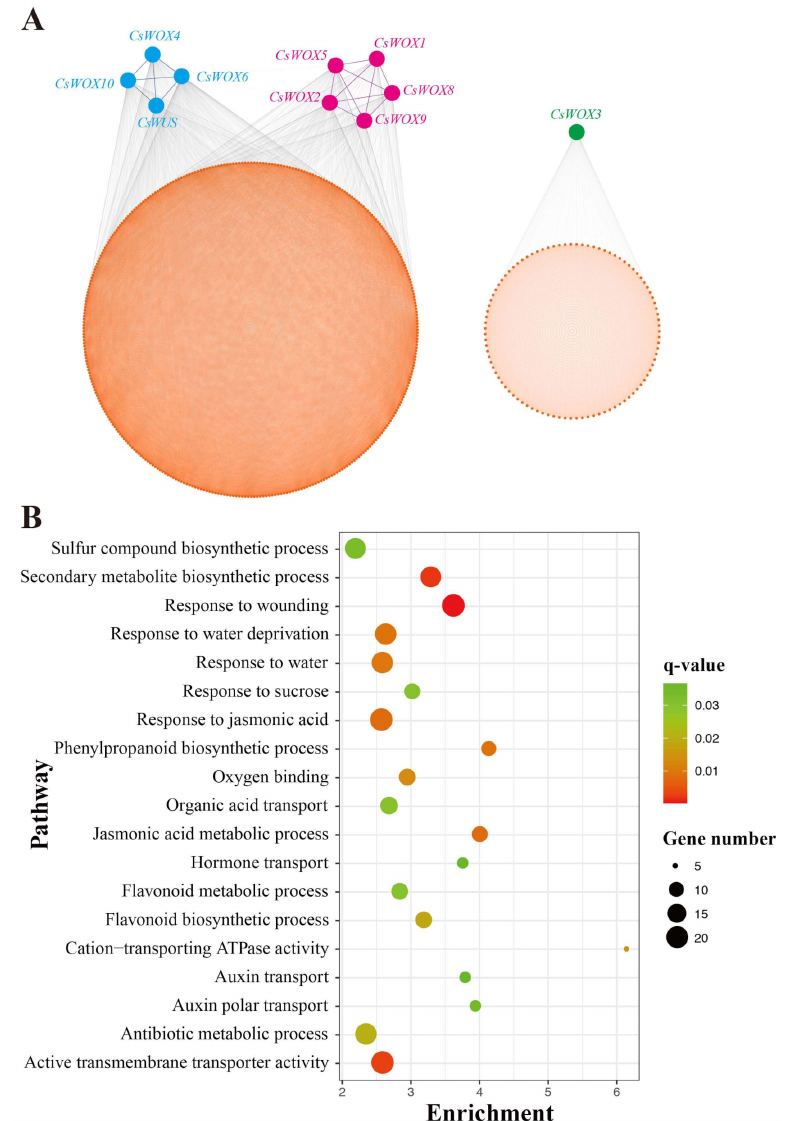
Figure 4. Co-expression network analysis of CsWOXs using data from a previous study [51]. ( A ) CsWOXs centered gene co-expression network under floral inductive water deficit. ( B ) Bio- logical processes of Gene Ontology (GO) terms that were significantly augmented in CsWOX gene targeted